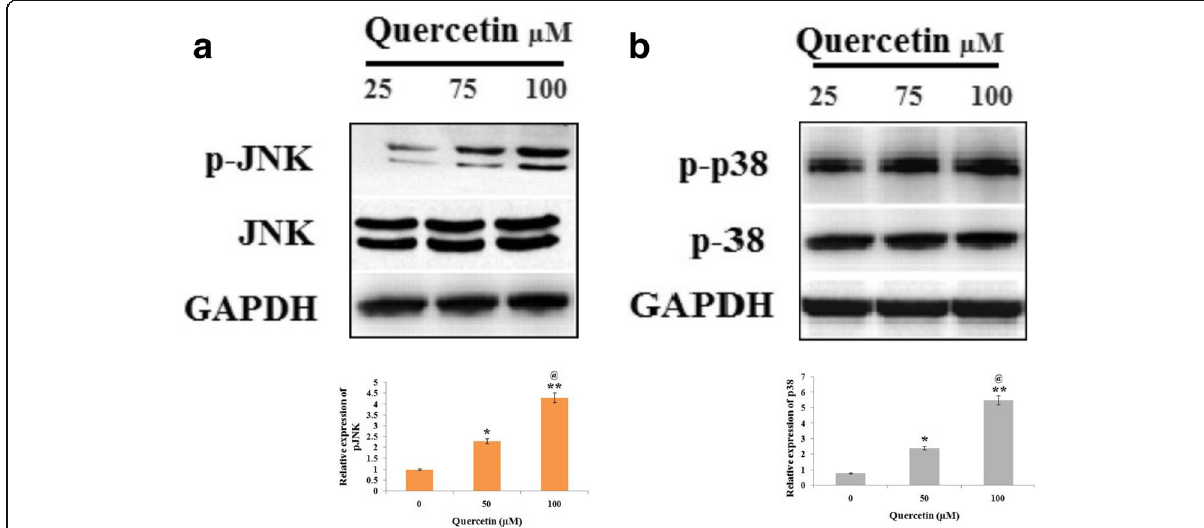
Fig. 5 Quercetin causes phosphorylation of c-Jun N-terminal kinase (JNK) and p38 mitogen-activated protein kinase (MAPK) in RB Y79 cells. a and b The RB Y79 cells were treated with various concentrations of Quercetin (0-100 μ M) and incubated for 24 h. The levels of phosphorylated (p-)JNK and p38 MAPK were assessed by western blot, GAPDH was used as a loading control. *P < 0.05, ** P < 0.01 against control. @ P < 0.05 against Quercetin (50 μ M) (n =